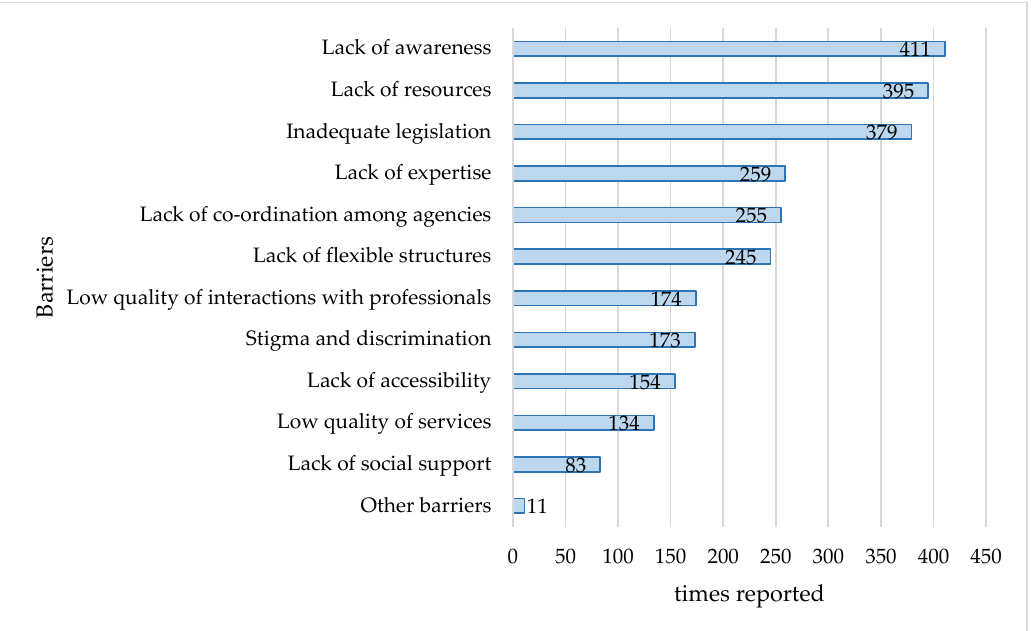
Figure 3. Most frequently referred barriers to the implementation of the recommendations.